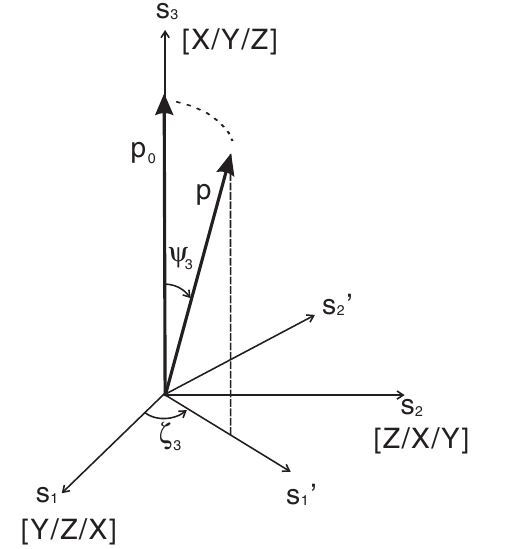
FIG. 15. Coordinate system for defining the orientation error of a linear stage and the position of the Hall probe. The coordinate system ð s 1 ; s 2 ; s 3 Þ is defined for a linear stage with no orientation error and s 3 is its moving axis. The orientation error of the moving axis is defined by the angles ð c 3 ; (cid:8) 3 Þ . The vectors p 0 and p show positions of the Hall probe without and with the angular error,